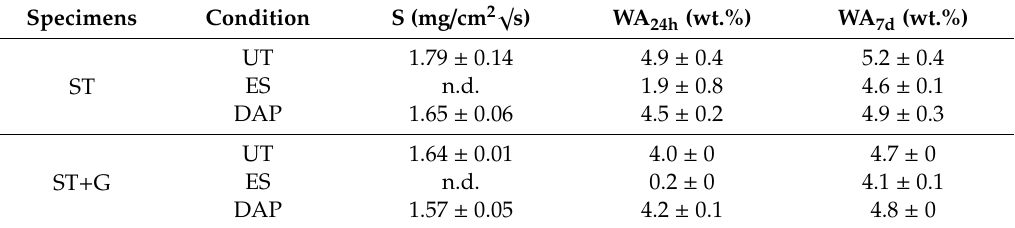
Table 2. Water transport properties of untreated and treated specimens.